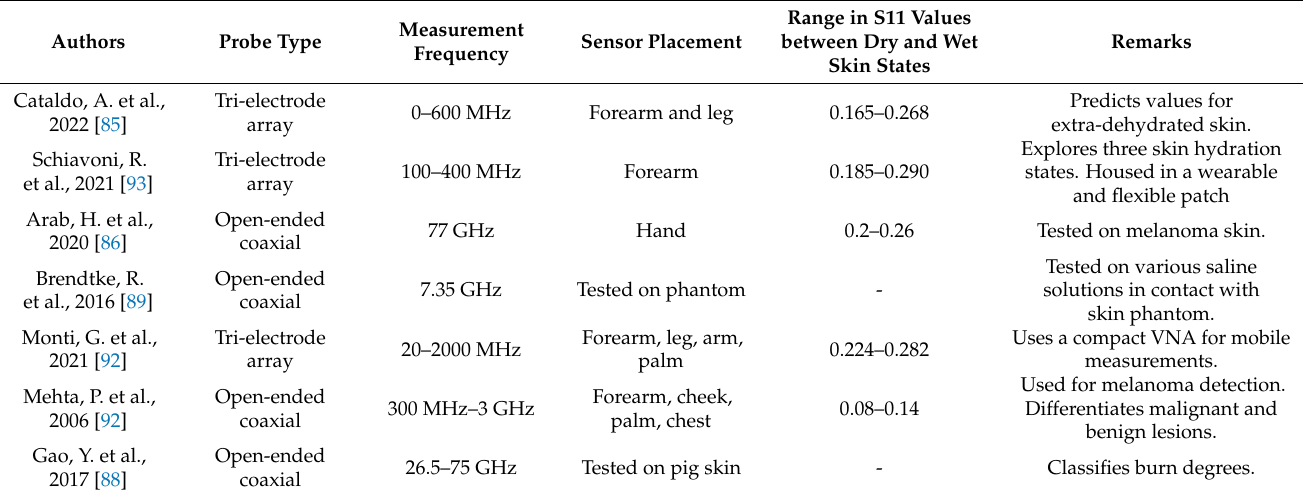
Table 3. Summary of literature findings of RF reflectometry for the purposes of AD and skin condition